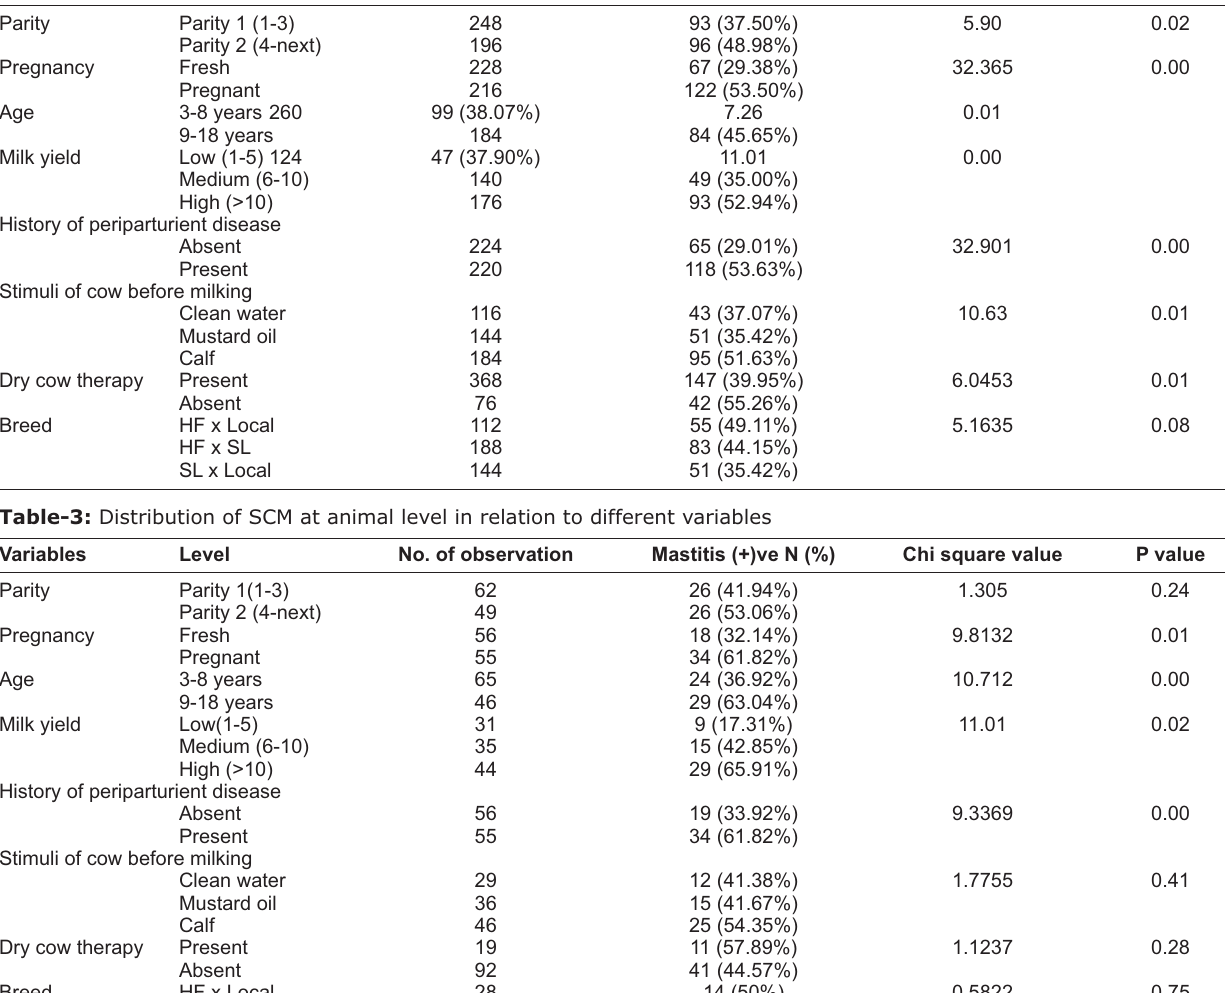
Table-2: Distribution of SCM at quarter level in relation to different variables Variables